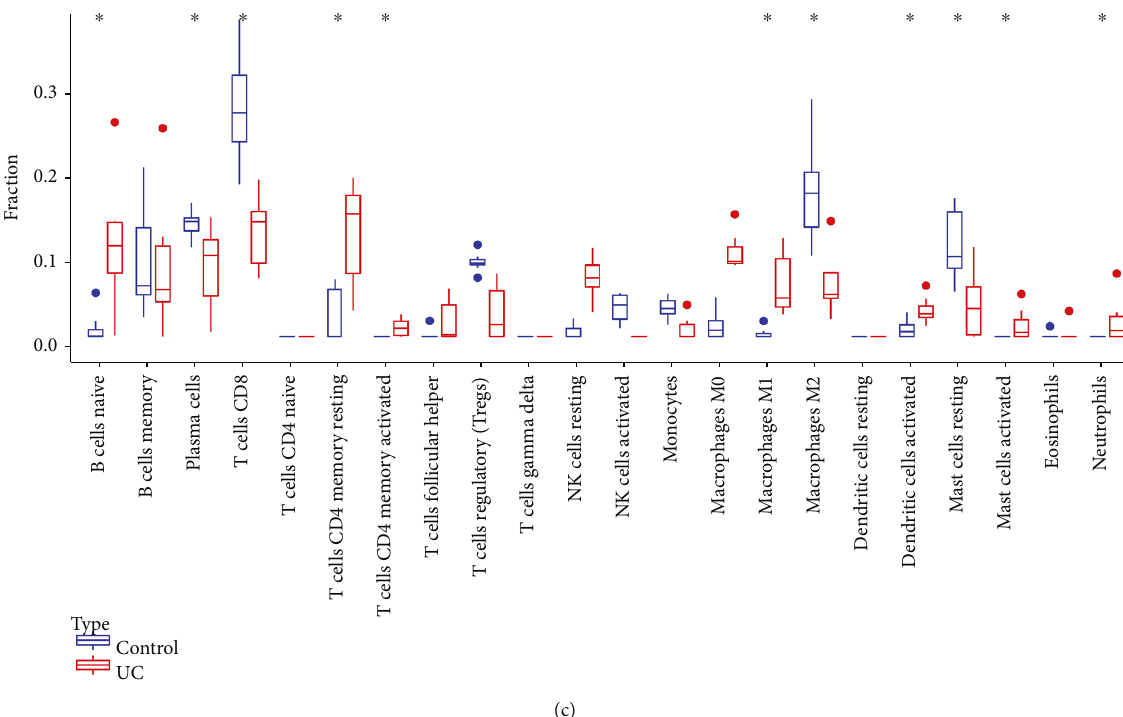
Figure 2: Identi fi cation of immune cell composition and di ff erential analysis in UC samples. (a) Analysis of immune cell composition in UC samples. Abscissa indicates sample number, and ordinate indicates relative percent of immune cells. Di ff erent colors in the bar chart indicate di ff erent types of immune cells. (b) Heat map of immune cell component, wherein the abscissa indicates sample number, the ordinate indicates immune cell name, and the upper right histogram is color level. (c) Proportions of immune cell components in the control (blue) and UC (red) groups. ∗ indicates p < 0 : 05 versus control